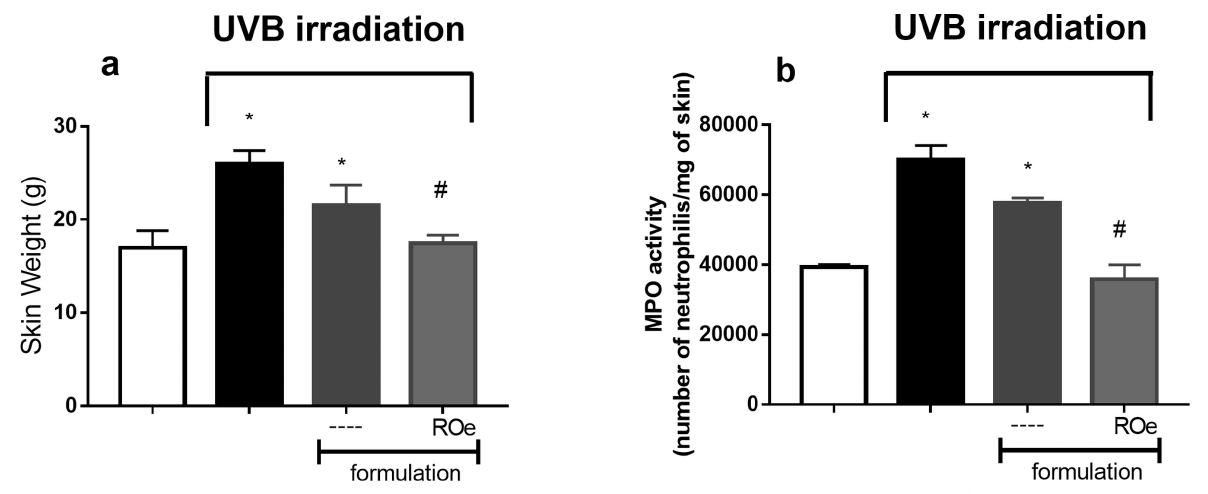
Figure 3. Topical formulation containing ROe reduces skin edema induced by UVB irradiation ( a ) and inhibit the UV-B irradiation-induced increase of MPO activity ( b ). Samples of dorsal skin were collected 12 h after the end of irradiation and used to measure the edema. Bars represent means ± SEM of 5 mice per group per experiment and are representative of two separate experiments. * p < 0.05 compared to the non-irradiated control groups (white bars); # p < 0.05 compared to the irradiated control groups (black